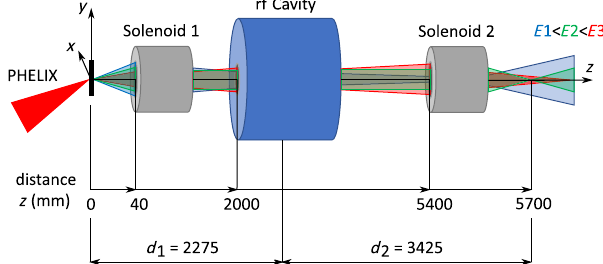
FIG. 1. Schematic illustration of the LIGHT beamline with the most important distances and the coordinate system used in this